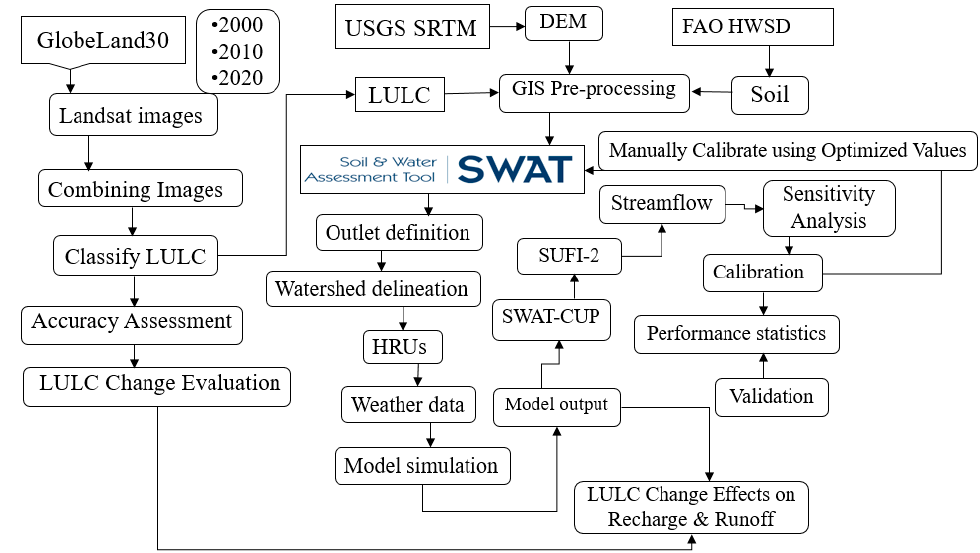
Figure 3. The general workflow design of the study methodology.